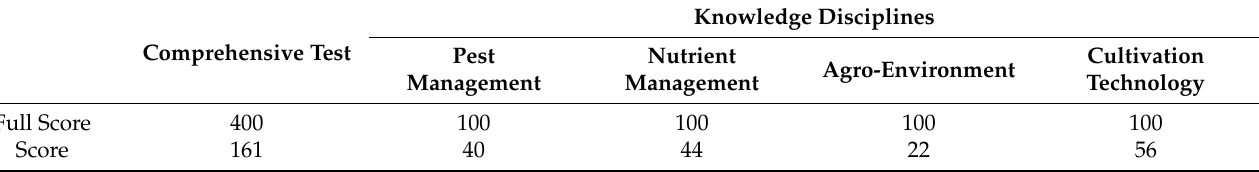
Table 1. Agricultural production knowledge research design and simple statistics.